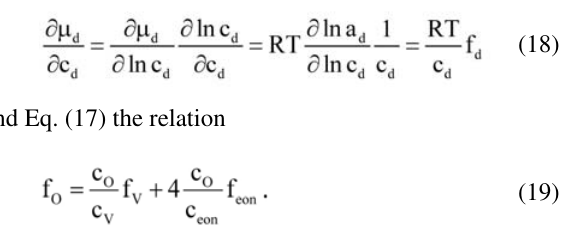
and Fe-doped SrTiO 3